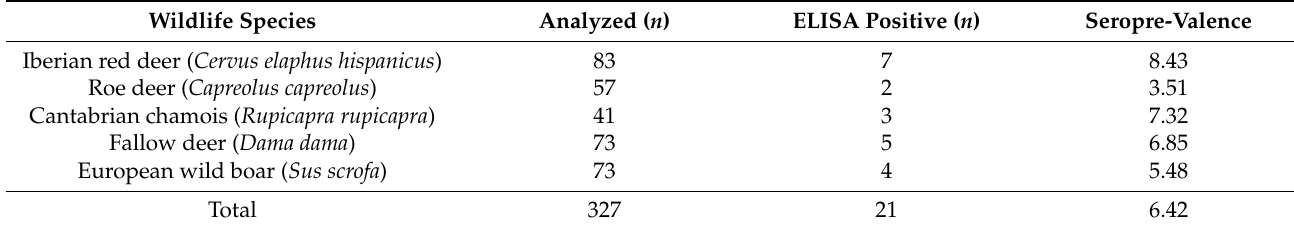
Table 3. C. burnetii seroprevalence in wild ungulates from Asturias.